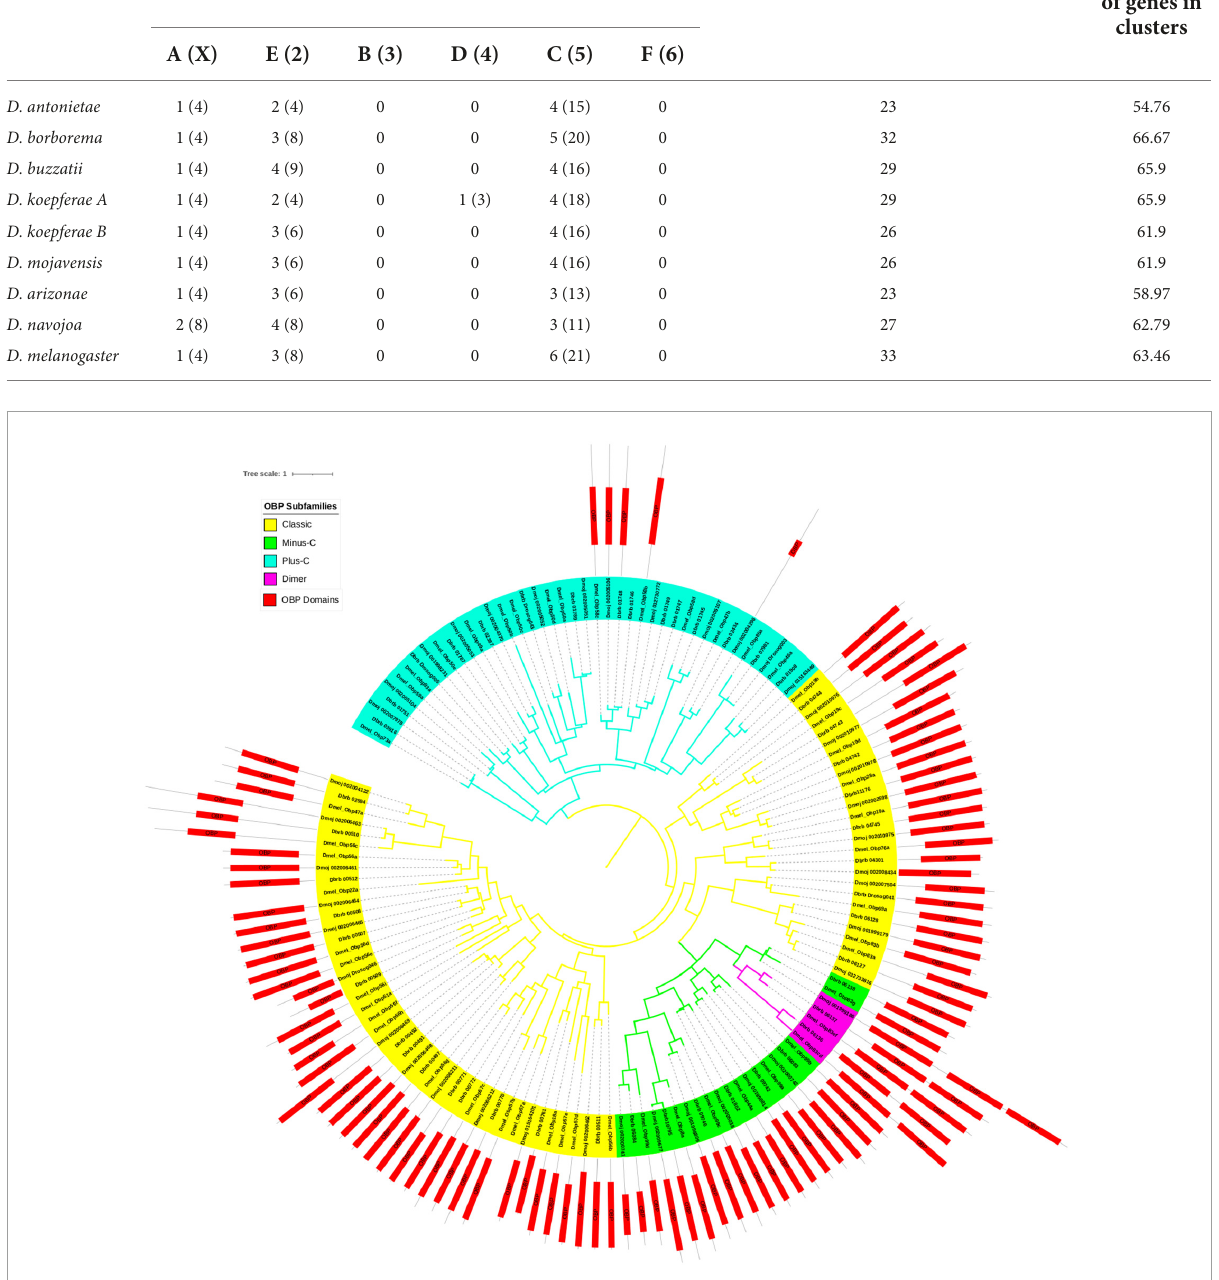
FIGURE2 Phylogeny using amino acid sequences of OBPs for three Drosophila species: D. melanogaster , representing the melanogaster group, and D. borborema and D. mojavensis, representing the repleta group. Branch colors represent the Classic (yellow), Plus-C (blue), Minus-C (green), and Dimer (purple) subfamilies. The outer part of the tree shows the protein length and location of the OBP/PhBP domains (red). The scale bar refers to 1 amino acid substitution per